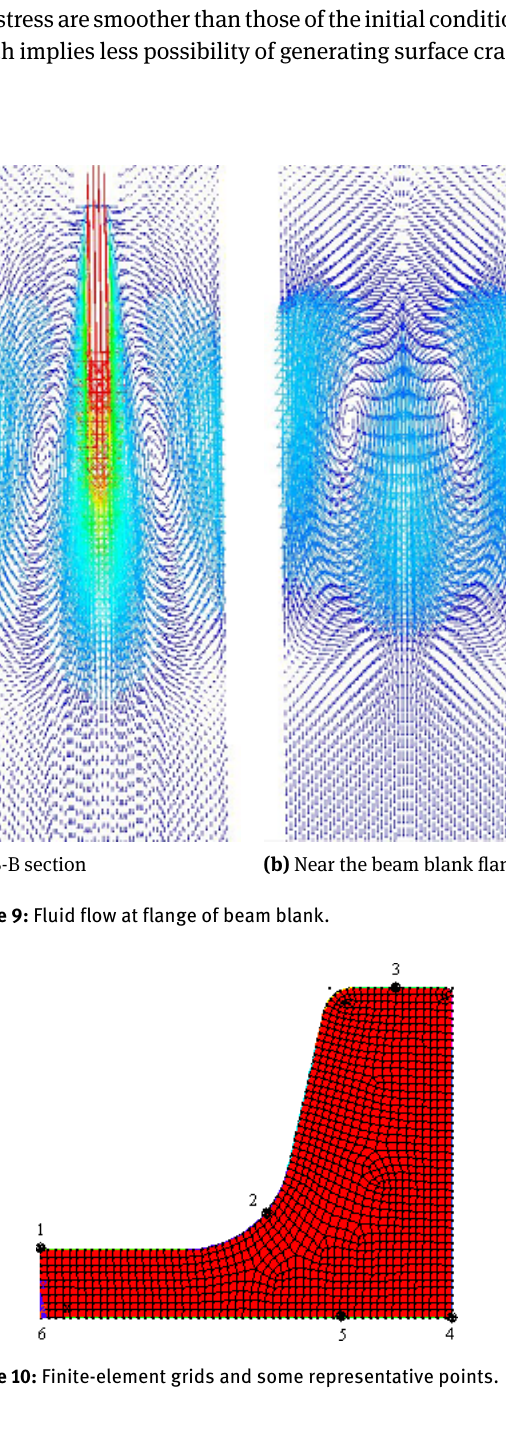
Figure 13: Comparison of initial and optimized stresses on surface